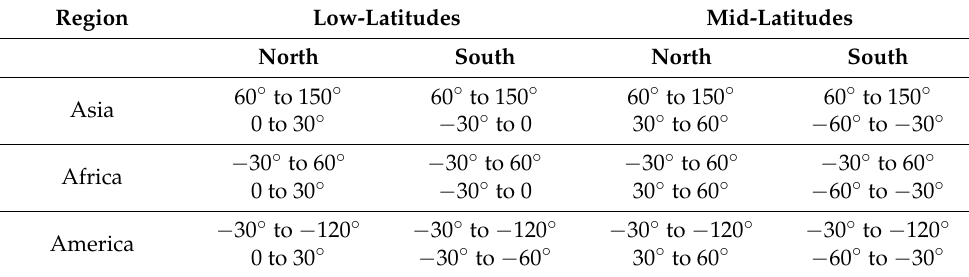
Table 2. Geographic coordinates of low- and mid-latitudes longitudinal regions. Region Low-Latitudes Mid-Latitudes North South North South Asia Africa America